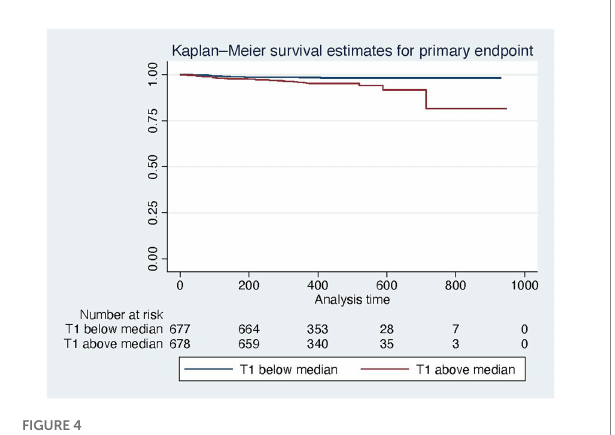
FIGURE 4 Kaplan Meier survival curves for the primary endpoint for patients below (blue) and above (red) the median native T1